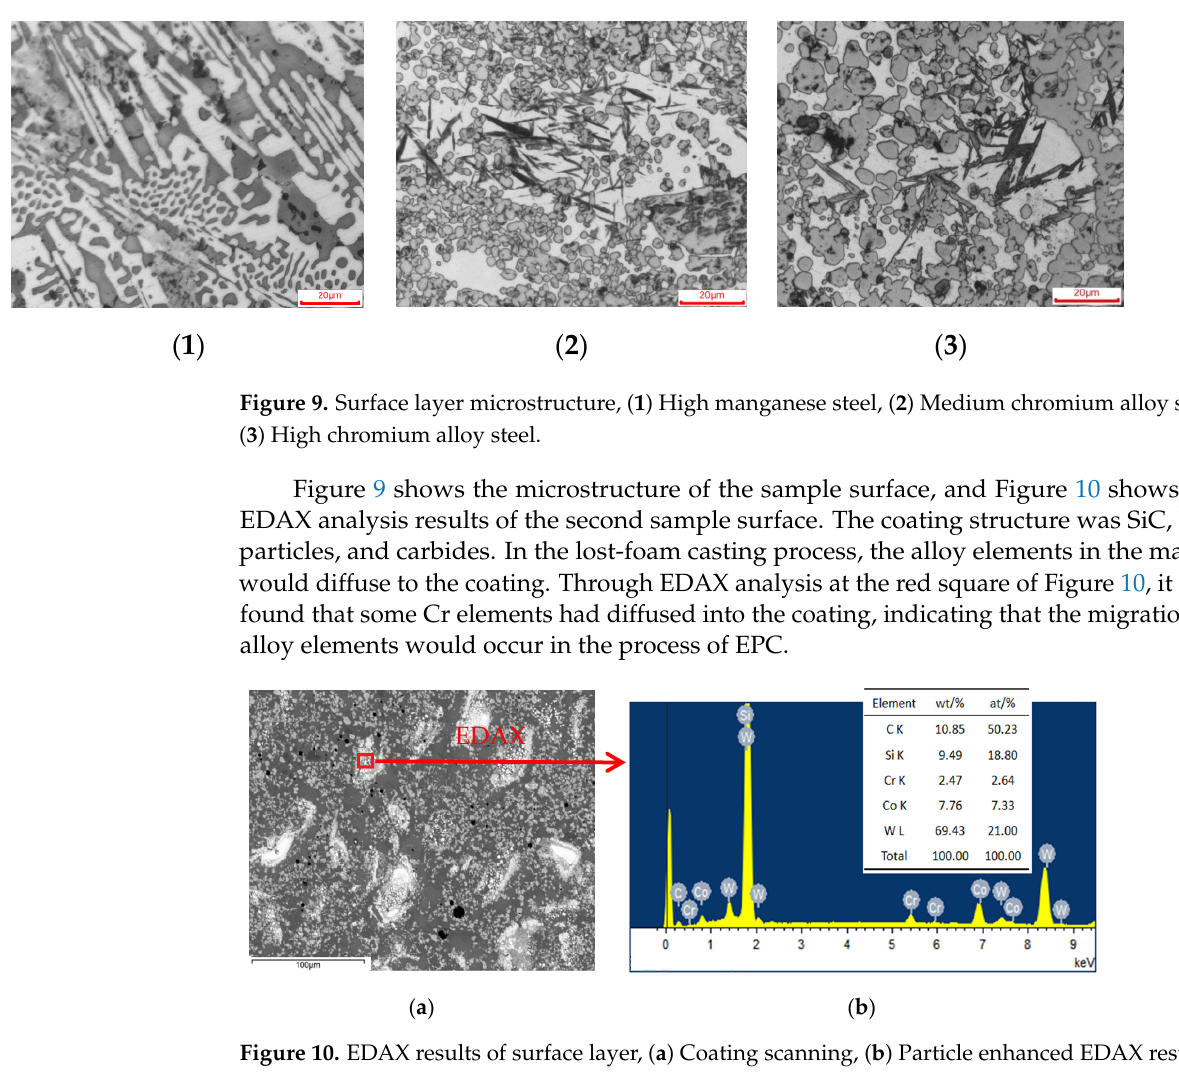
Figure 10. EDAX results of surface layer, ( a ) Coating scanning, ( b ) Particle enhanced EDAX results.